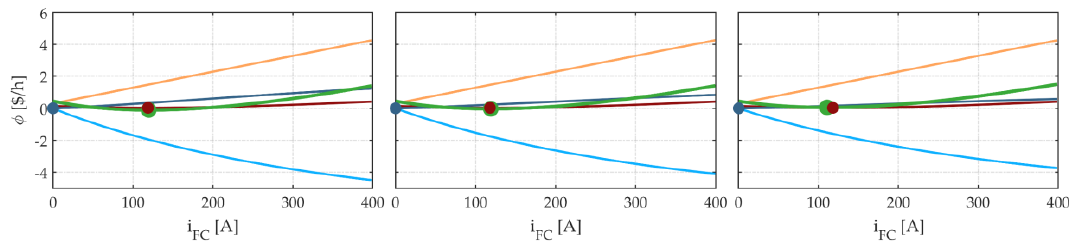
Figure 3. Evolution of the cost functions with i FC at p M = −8 kW and ε B = 0.3 ( left ), 0.5 ( middle ) and 0.7 ( right ), in which the minimum value of some curves has been highlighted by a dot: φ FC (red), φ H2 (orange), φ B (blue), φ ST (cyan), and φ (green).